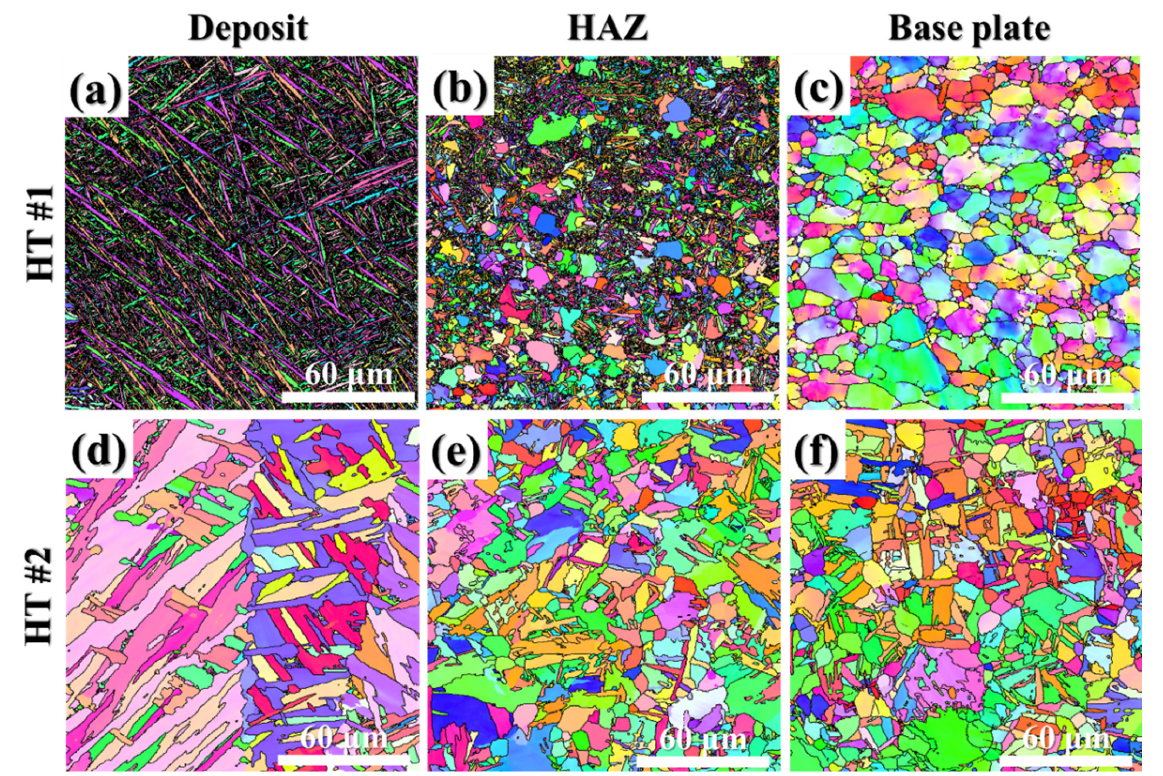
Figure 9. Electron backscatter diffraction–inverse pole figure maps of the deposition region, heat-affected zone (HAZ), and base plate of the DED-processed Ti–6Al–4V component after heat treatment: ( a – c ) HT #1 and ( d – f ) HT #2.